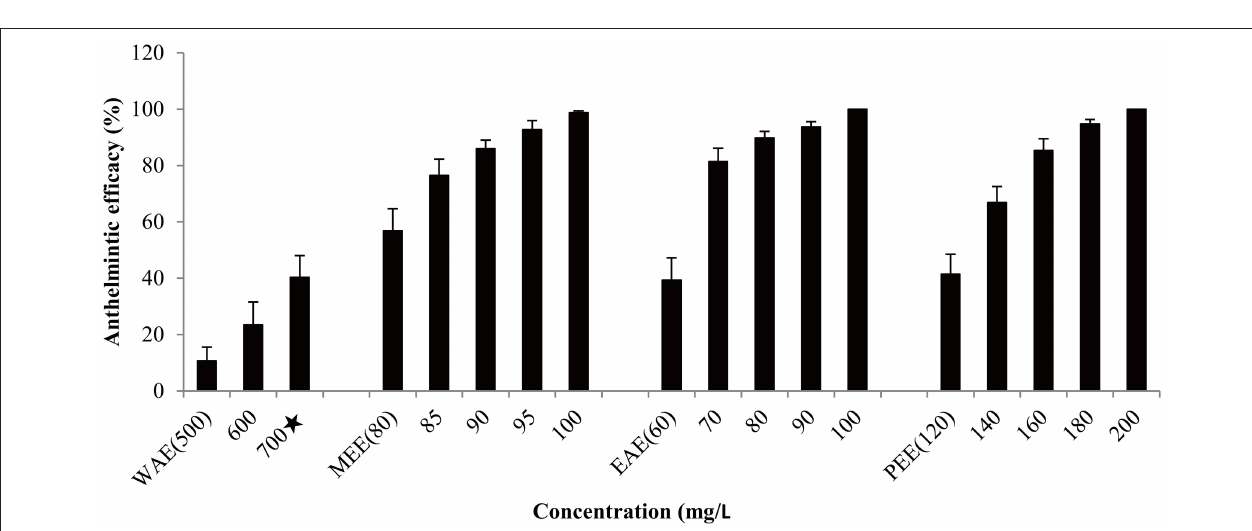
Frontiers in Veterinary Science |